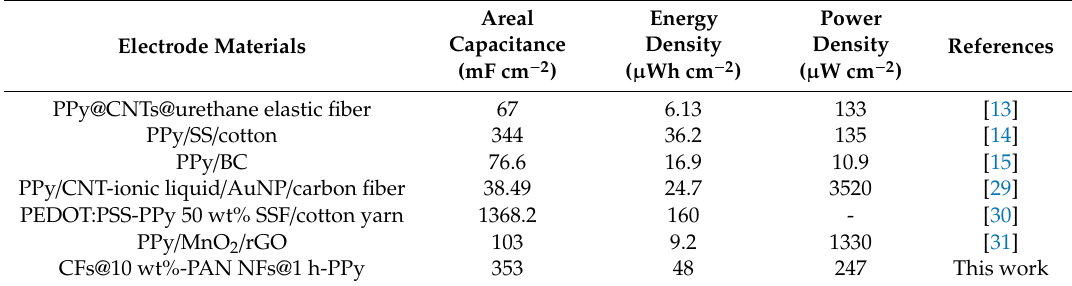
Table 1. Comparison of PPy-based